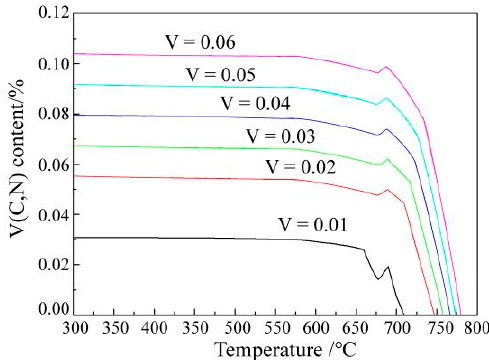
Figure 3. Calculated dissolution and precipitation laws of the different V contents in the samples.